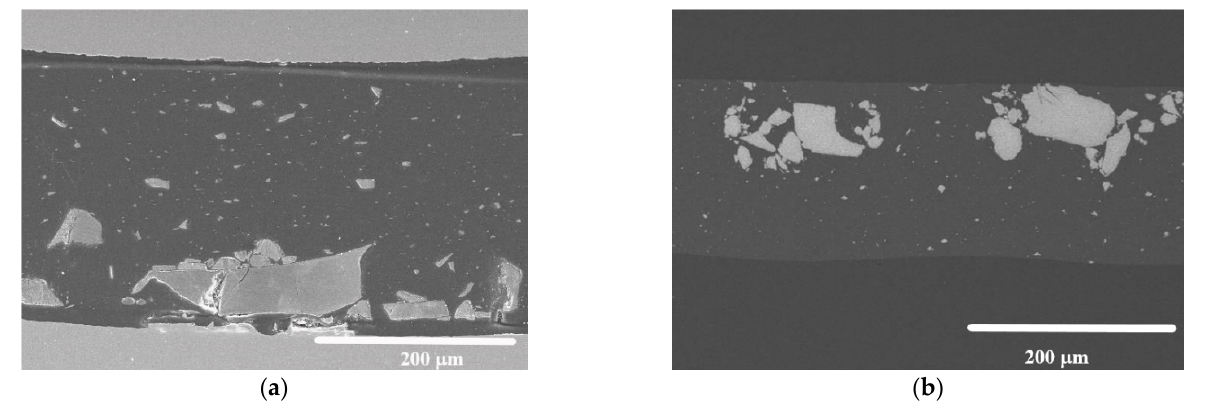
Figure 2. Cross section SEM micrographs. ( a ) As-prepared PLLA13Fe (secondary electron image); ( b ) as prepared PLLA9Mn (back-scattered electron image, BSE).